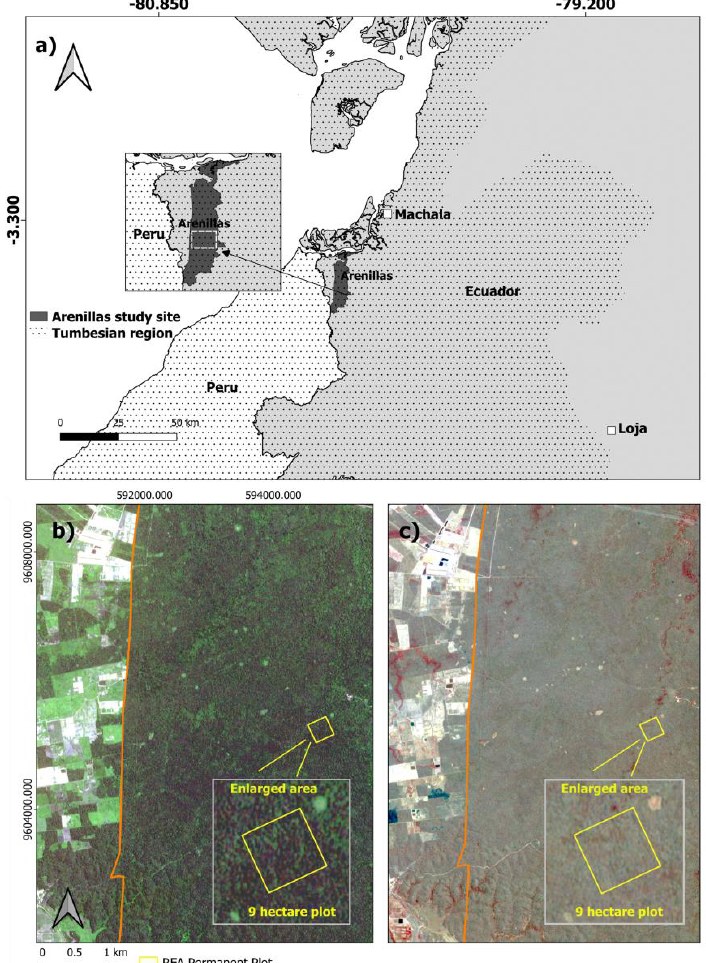
Figure 1. The 9 ha study area location within the ( a ) Arenillas Ecological Reserve (REA) and Tumbesian biogeographic region in southern Ecuador. RapidEye imagery from 2019 displays the ( b ) leaf-on period (April) using a blue, green, and red band combination, and ( c ) leaf-off period (September) using a NIR, red and green band combination. An enlarged study area (gray box) for ( b ) and ( c ) shows seasonal differences in greater detail.